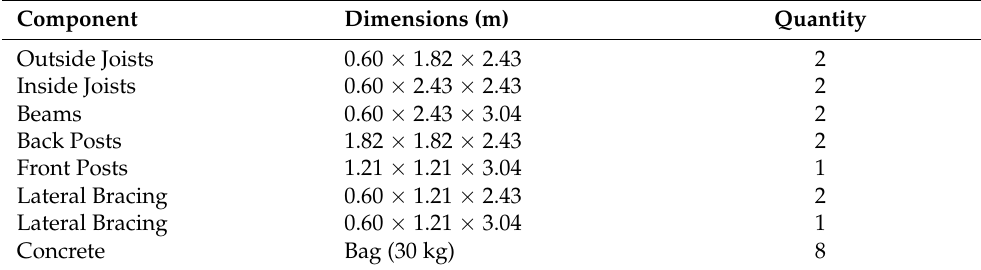
Table 1. Simplified BOM for the fixed-tilt wood-based PV racking system.